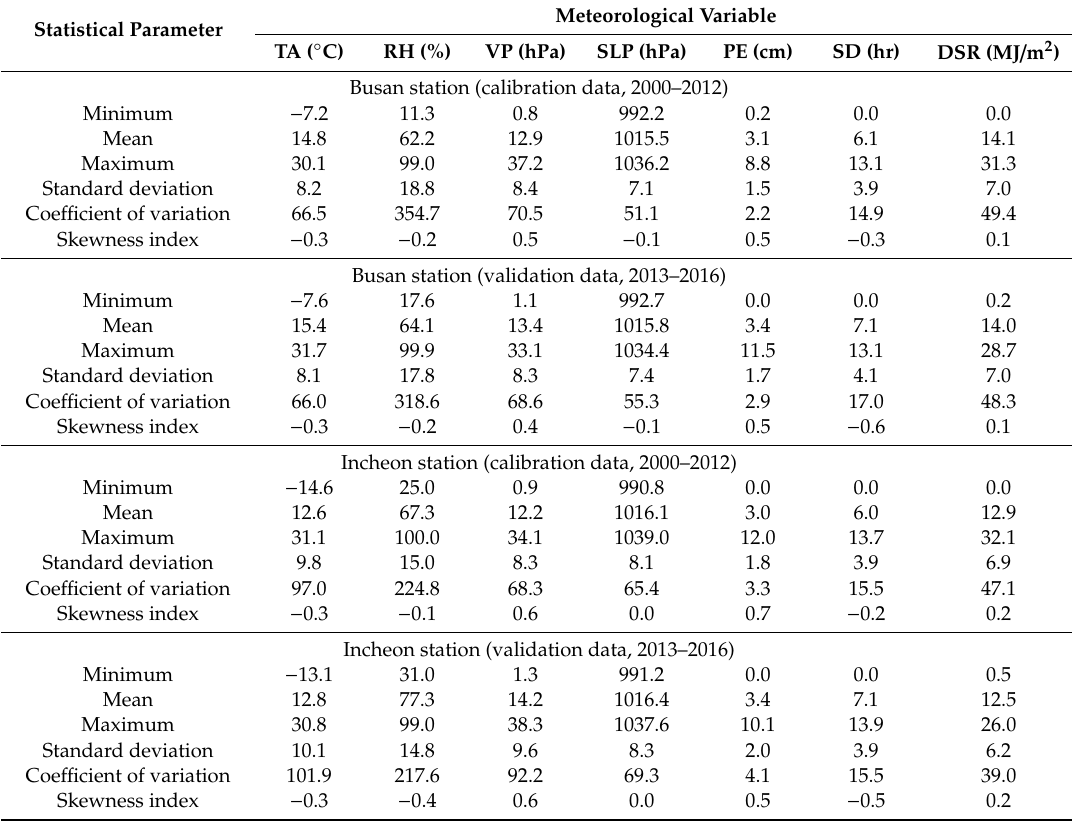
Table 1. Descriptive statistics of solar radiation data for the Busan and Incheon stations located in South